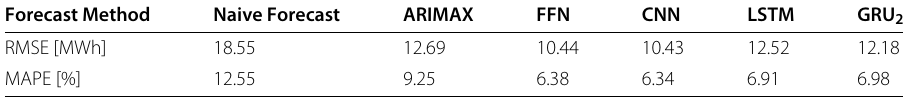
Table 2 24h forecast results for the Flensburg DHN Forecast Method